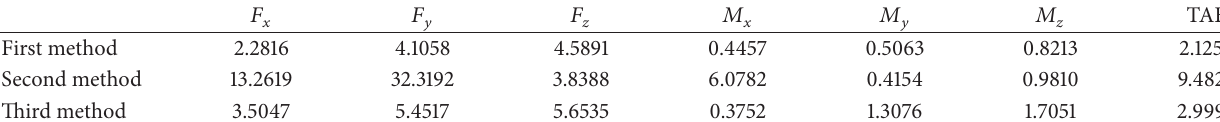
Table 4: Average error in dB calculated in the frequency range of 0–200 Hz.